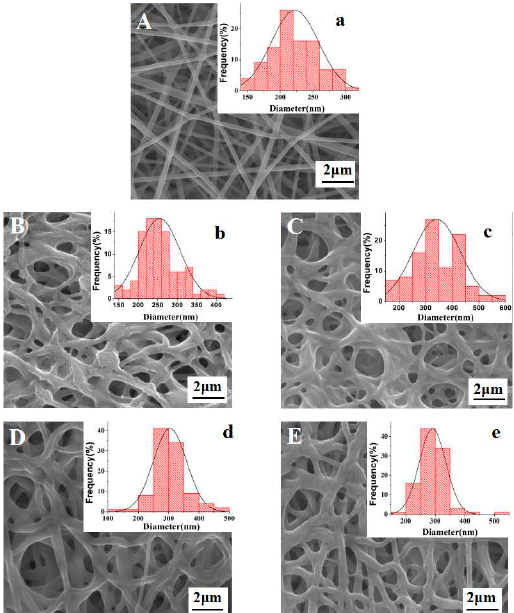
Figure 1. SEM images and diameter distributions of FK/PVA/PEO nanofiber membranes: ( A ) without treatment; ( B ) 3h-C; ( C ) 12h-C; ( D ) 3h-G; and ( E ) 12h-G. The insets show the diameter-distribution of corresponding samples (for example, 3h-C refers to the FK/PVA/PEO nanofiber membranes crosslinked by citric acid vapor for 3 h. C and G are the English initials abbreviation of citric acid and glyoxal, respectively; 3 h is the crosslinking time).